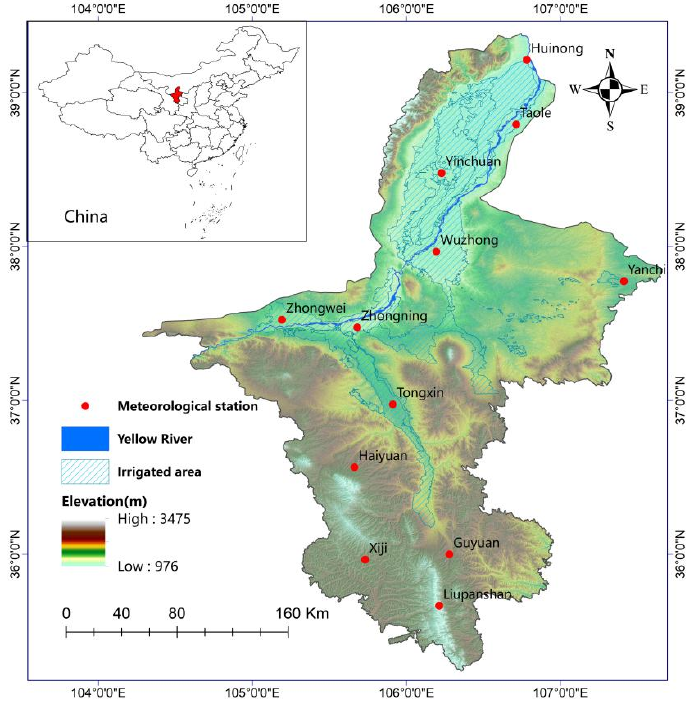
Figure 1. Geographical location and terrain of Ningxia.